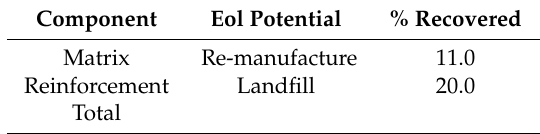
Table 10. Disposal phase (energy inputs, outputs) for reference composite.